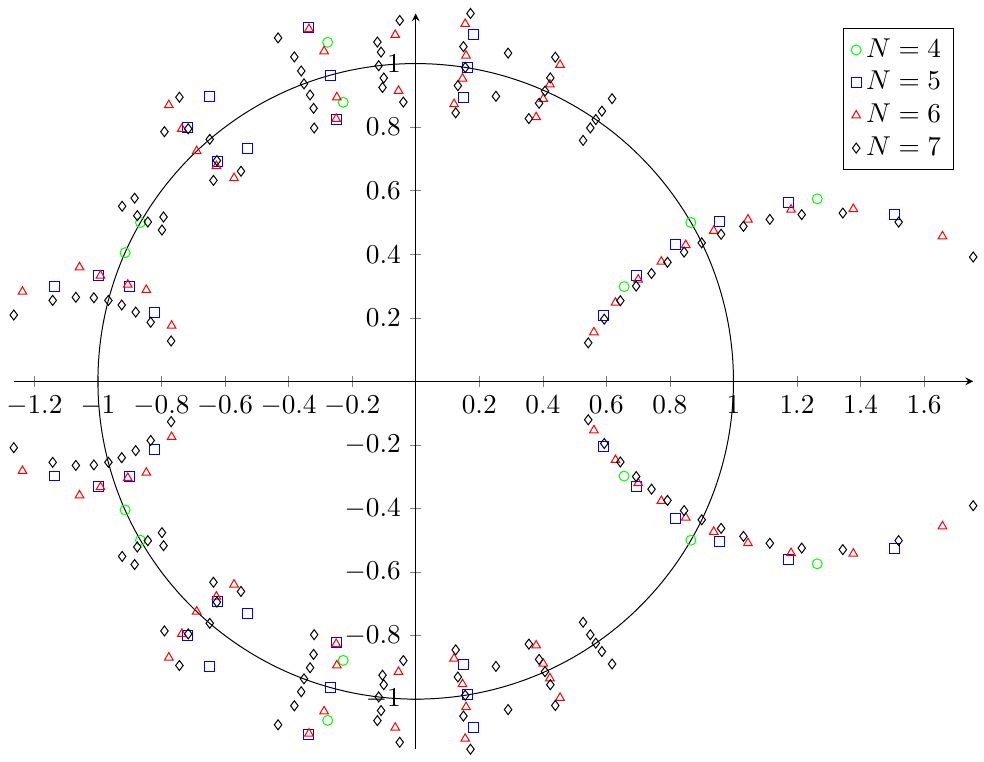
Figure 1 . Zeros of the su (2) partition functions for N = 4 : : : 7 plotted in the complex plane of x = e (cid:0) 1 =T . The right-most zeros appear to ‘condense’ in two arcs pinching the real axis just around the Hagedorn temperature x su (2) ; tree = 1 = 2 of the in(cid:12)nite- N theory. This hints at a phase transition H of Lee-Yang